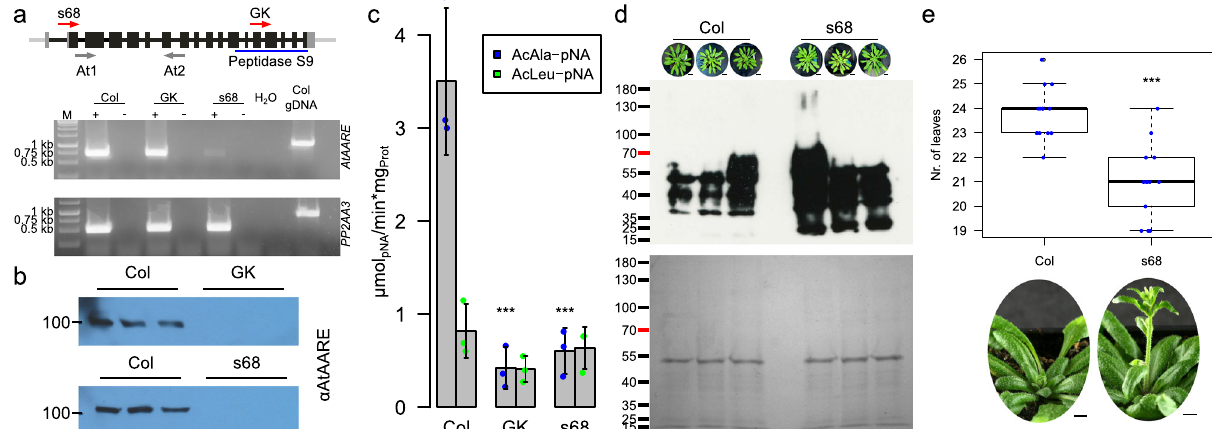
Fig. 6 Molecular and phenotypical characterization of A. thaliana T-DNA mutant lines. a Structure of the AtAARE gene and positions of T-DNA insertions (red arrows indicate positions of T-DNA insertion, s68 (SALK_071125) and GK (GK-456A10)) and primers (At1, At2) used for RT-PCR (below). Transcription analysis of AtAARE was performed by RT-PCR in WT (Col), s68, and GK plants. Negative controls without reverse transcriptase (-), a water control (H 2 O) and genomic DNA control (gDNA) are indicated. Expected amplicon sizes: AtAARE : cDNA 739 bp, gDNA: 1204 bp; PP2AA3 (reference gene): cDNA: 517 bp, gDNA: 911 bp. Primers are listed in Supplementary Data S3. b Western blot analysis on extracts of the two T-DNA mutants and WT probed with a polyclonal anti-AARE antibody. In both T-DNA lines AtAARE is not detectable. Full blot images are available in Fig. S10. c Mean exopeptidase activity in A. thaliana extracts on AcAla-pNA and AcLeu-pNA with standard deviation ( n = 3 biological replicates). Signi fi cance levels are based on one-way Anova and subsequent post-hoc test (*** p < 0.001) and indicate differences compared to WT (Col). d Detection of oxidized proteins in WT (Col) and AtAARE mutant (s68). From three independent plants one exterior rosette leaf was taken after cultivation for 8 weeks in short-day conditions (8 h light/ 16 h dark). Bars correspond to 2 cm. Protein loading control by Coomassie staining is depicted below. e Box plot of the bolting analysis of WT (Col, n = 14) and AtAARE mutant plants (s68, n = 13). The box plot ( e , f ) depicts the mean (horizontal bold line) of the data, the interquartile range (box) and the 1.5x interquartile range (whiskers). Outliers are depicted as white dots. Signi fi cance level is based on a one-way Anova and subsequent post-hoc test (*** p < 0.001). Exemplary plants (45-day-old plants grown in long-day conditions, 16 h light/8 h dark) are depicted below the box plot. Bars correspond to 1